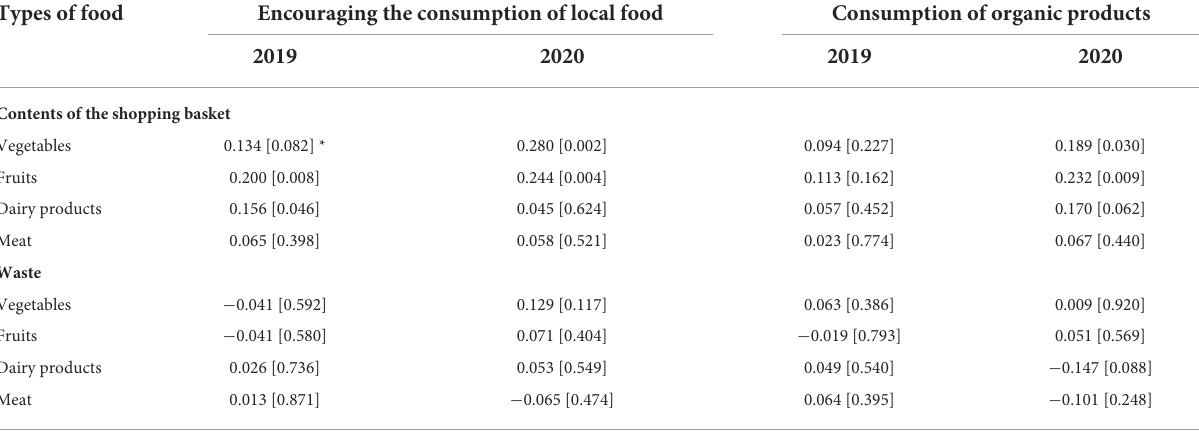
TABLE 2 Associations between the shopping basket components and the orientations toward local and organic food. Types of